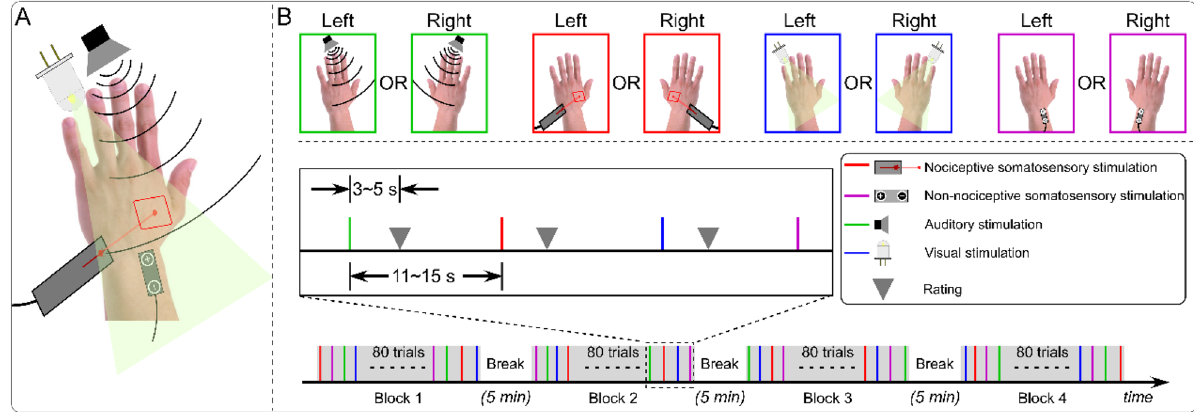
Figure 5. Experimental design. ( A ) Transient stimuli belonging to four different sensory modalities (nociceptive somatosensory, non-nociceptive somatosensory, auditory, and visual). ( B ) The experiment consisted of four blocks, and in each block, there were 80 trials with transient stimuli belonging to four different sensory modalities (nociceptive somatosensory, non-nociceptive somatosensory, auditory, and visual). In two blocks, sensory stimuli were delivered to subject’s left side, and in the other two blocks, sensory stimuli were delivered to subject’s right side. The order of sensory modalities was pseudo-randomized, and the order of stimulated sides was counterbalanced across subjects. After each sensory stimulus, an auditory tone was delivered randomly between 3 and 5 s to prompt subjects to rate the perceived intensity on the 0–10 NRS verbally. The inter-stimulus interval (ISI) varied randomly between 11 and 15 s, and the interval between two consecutive blocks was 5